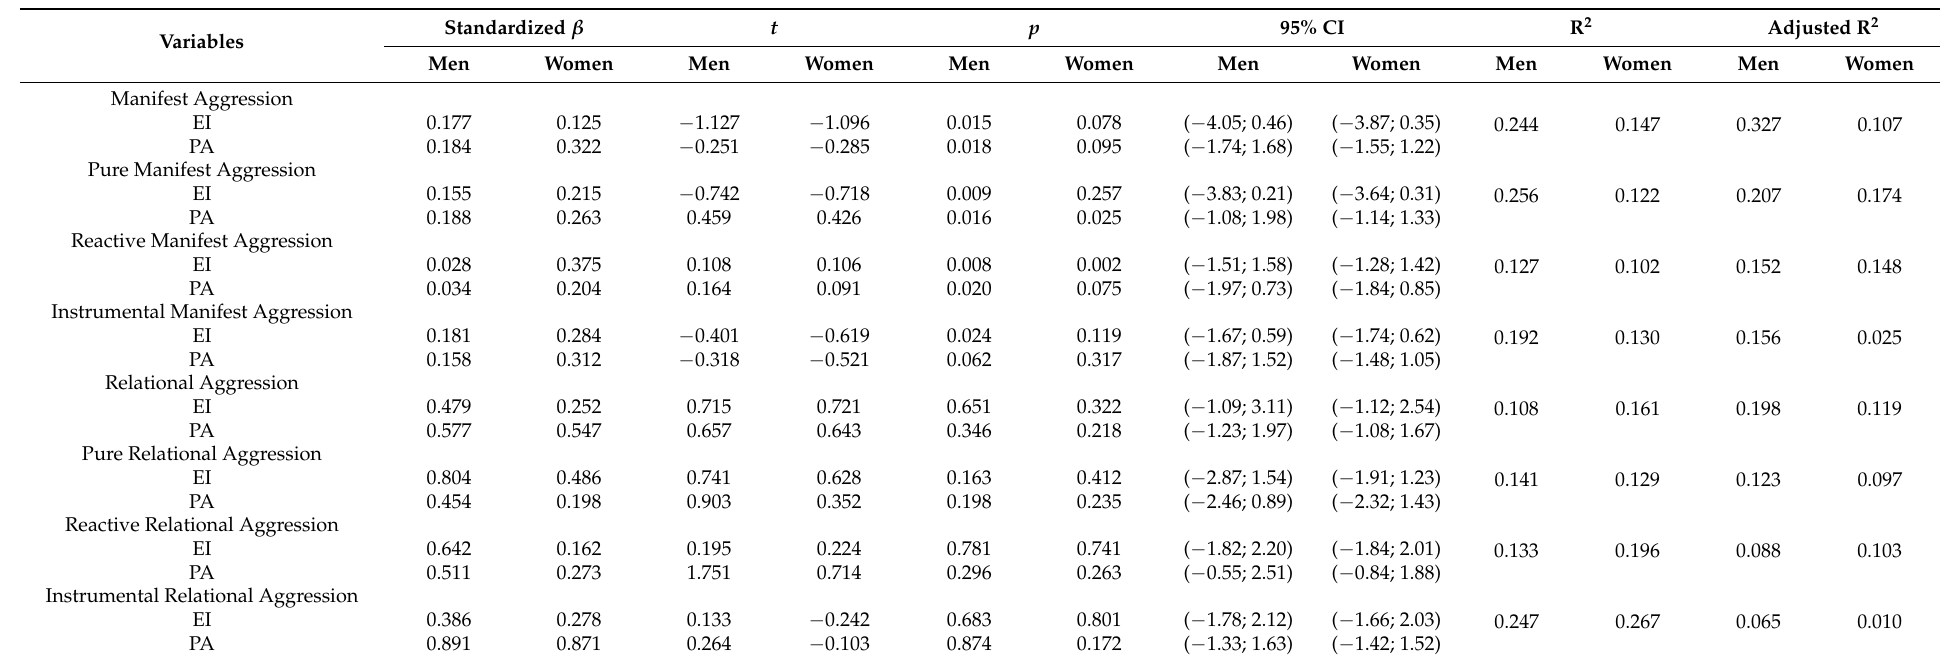
Table 4. Regression model for EI, PA and aggressive